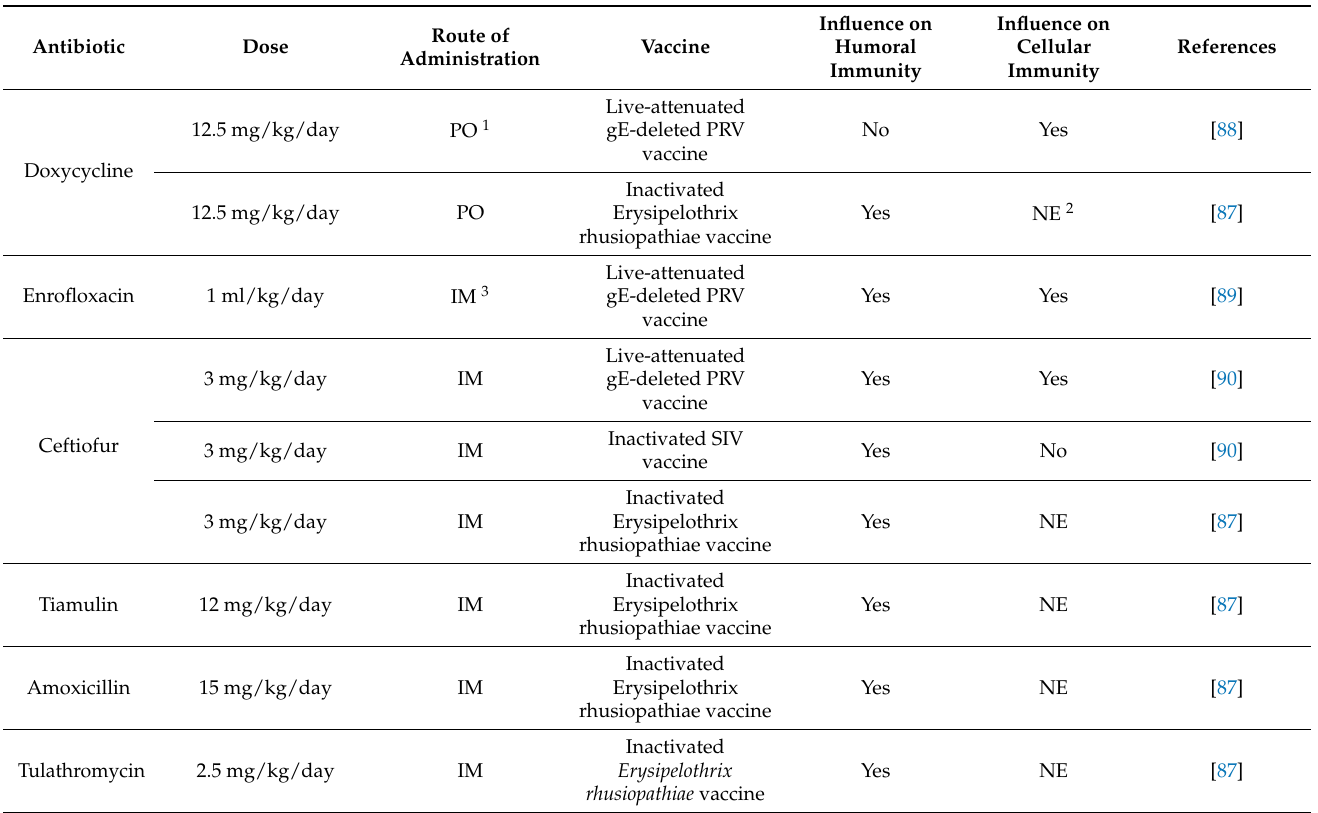
Table 2. Influence of concurrent antibiotic therapy and vaccination on the post-vaccinal immune